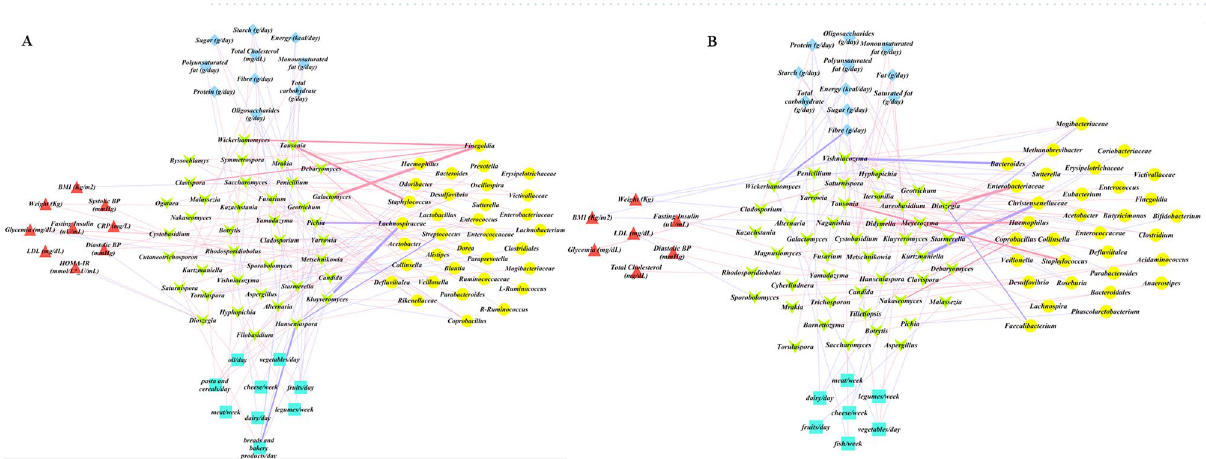
Figure 6. Correlation between mycobiota (green arrow), microbiota (yellow circle), dietary intake (light blue diamond), food frequency (gray square) and clinical variables (red triangle) in GDM patients in the second ( A ) or third trimester ( B ) of pregnancy. Correlation network shows the significant relationships based on Spearman’s correlations. Colors of the edges indicate positive (blue) or negative (red)